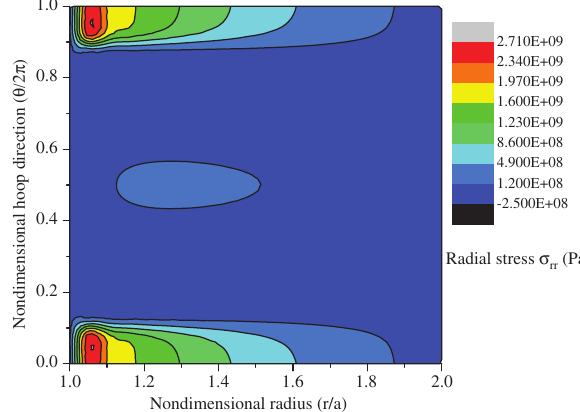
Figure 23 Contour map of radial stress in the FGM hollow cylinder, where t = 0.5 s.